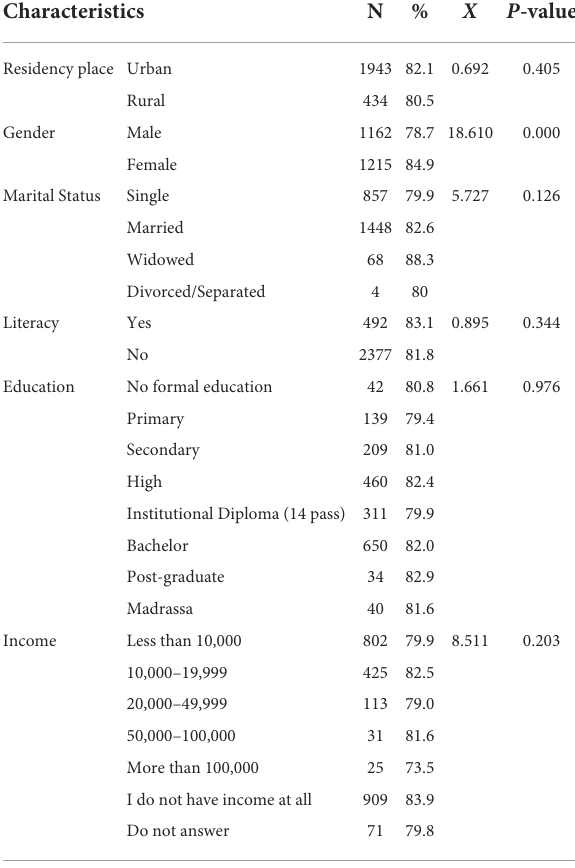
TABLE 5 Attitude score of COVID-19 by demographic